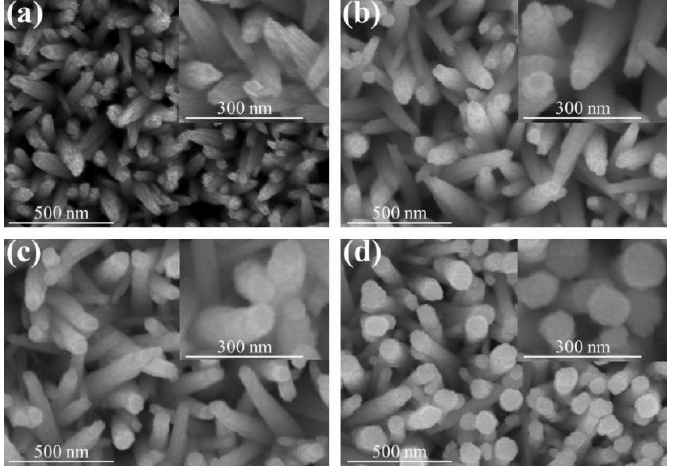
Figure 2. Scanning electron microscopy (SEM) images of various nanorods: ( a ) WO 3 , ( b ) WS-1, ( c ) WS-2, and ( d ) WS-3. The corresponding high magnification images are shown in the insets of the